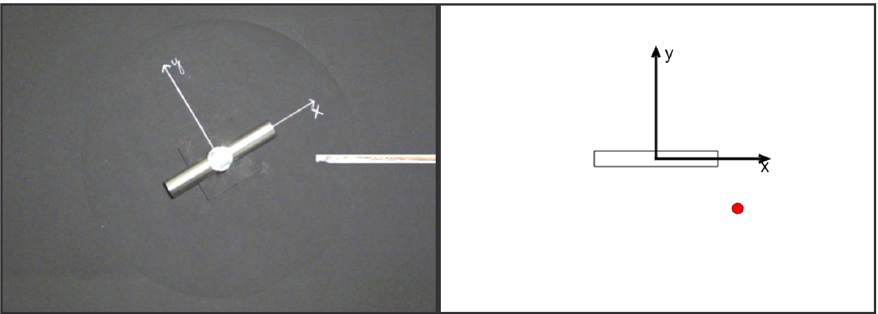
FIG. 6. Screenshot of the first part of the training in the reference group. The correct position is marked in red in the